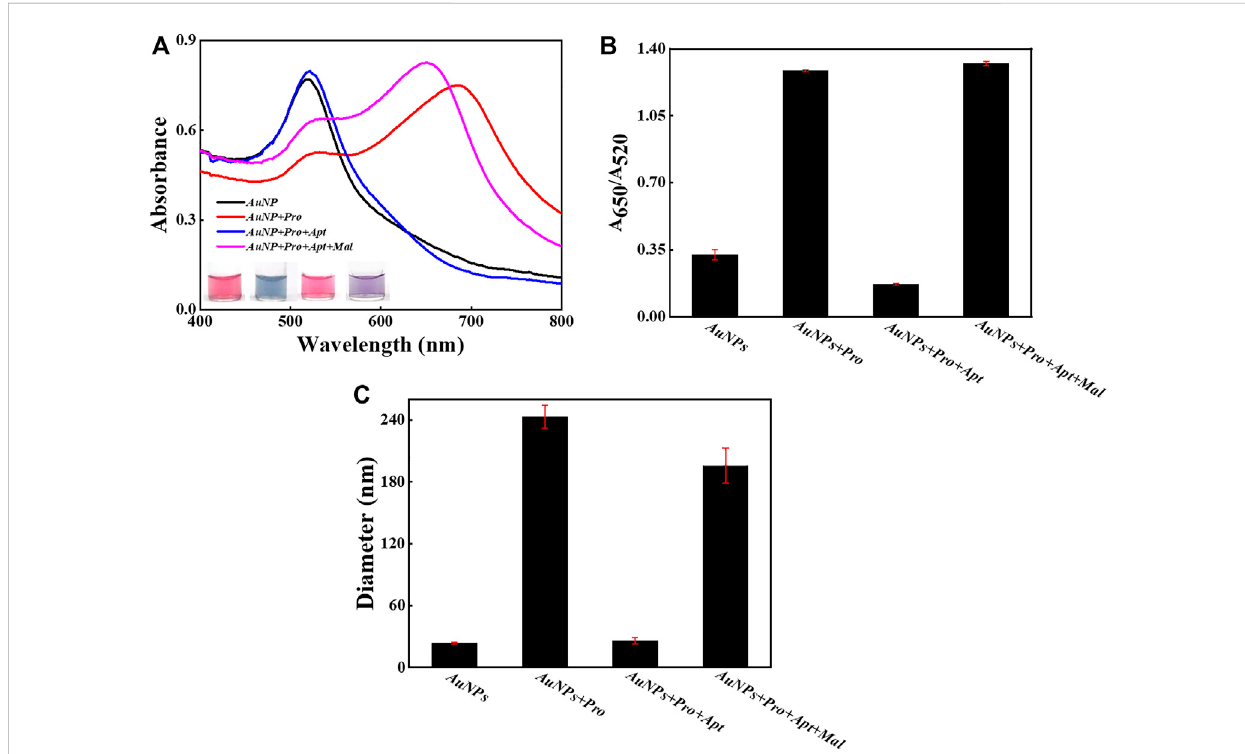
FIGURE 2 The feasibility examination. (A) The UV-Vis spectra of AuNPs and sample images with and without the introduction of malathion. (B) The values of A 650 /A 520 in different samples. (C) The DLS results in different samples. The error bars represent the standard deviation of three independent